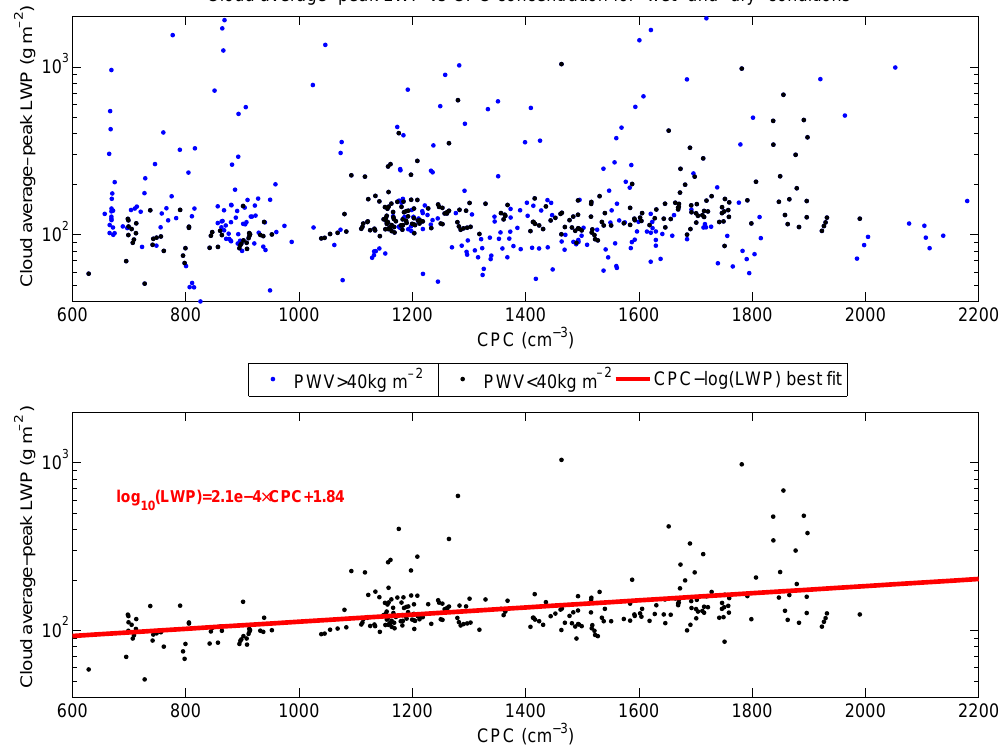
Figure 6. Cloud average-peak liquid water path vs. aerosol concentration, for all clouds (top; wet in blue, dry in black) and only dry condition clouds (bottom). Note the logarithmic scaling on the y axis. The red line indicates the linear best fit between CPC aerosol number concentration and